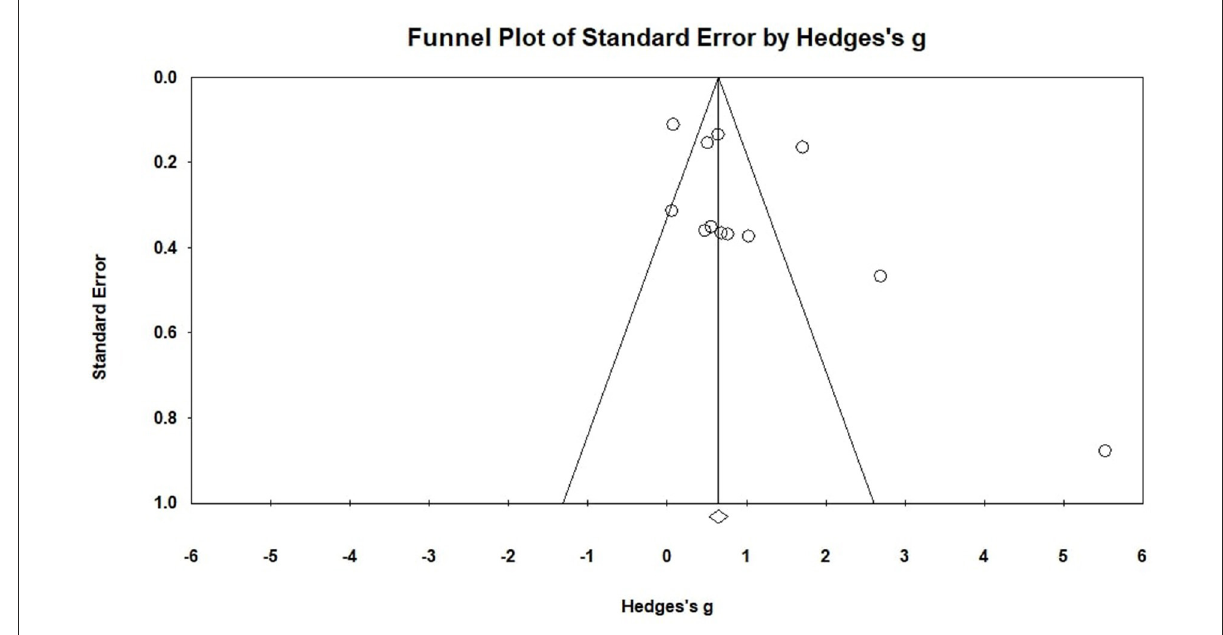
FIGURE3 Funnel plot of the overall mean ES analysis.